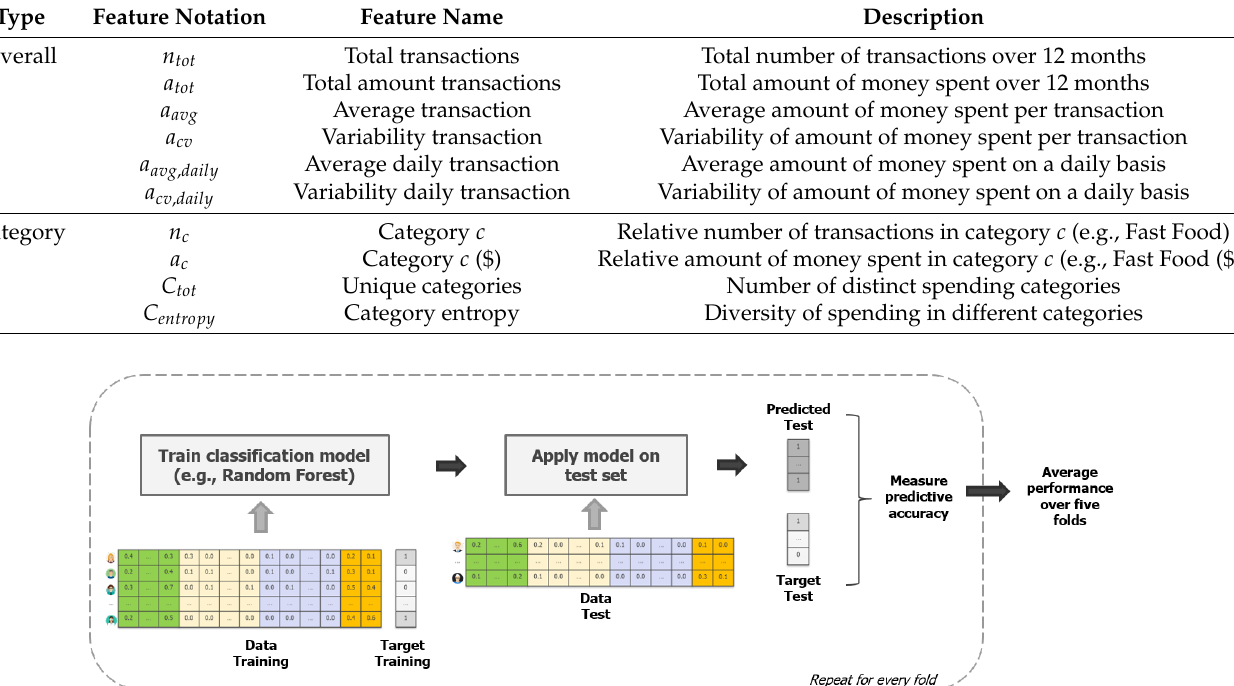
Table A2. Summary of features capturing spending behavior.